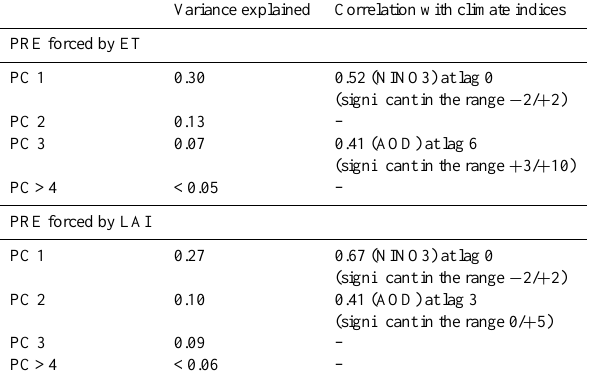
Table 7. Rainfall variability forced by the ET and LAI decomposed through EOF analysis. Each line displays the EOF explained vari- ance (column 2) and the corresponding PC correlation with rele- vant climatic indices (column 3). Here the maximum PC correla- tion is reported considering lagged correlations in the range − 16 to + 16. Only the correlation coefficients significant at 1% level are